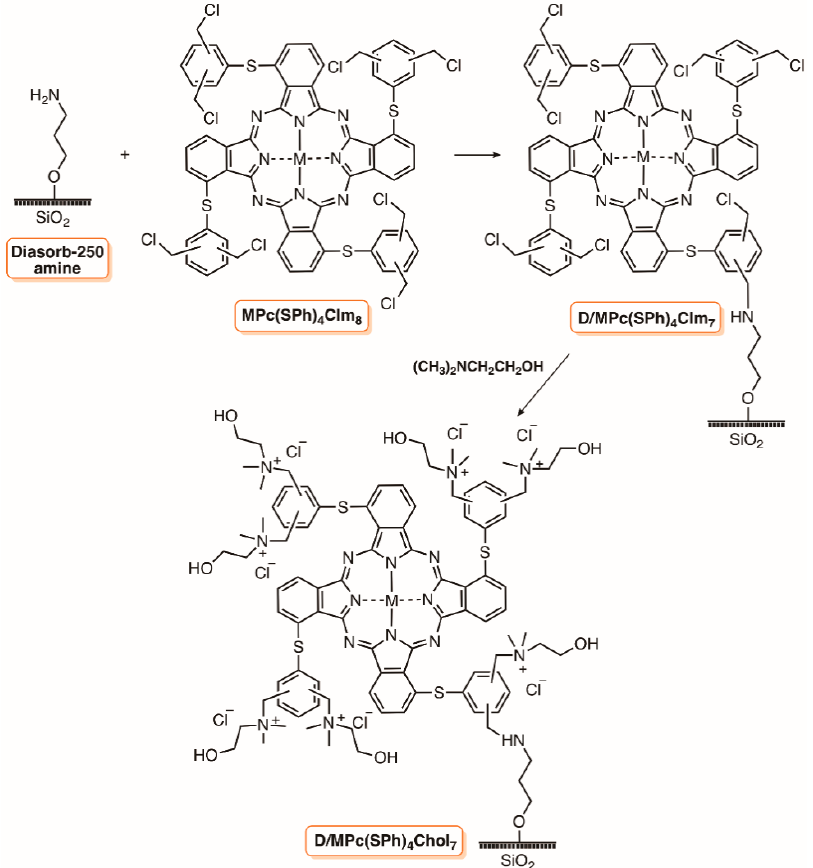
Figure 13. Synthetic route for the preparation of the metallophthalocyanines supported on silica materials (adapted from Reference [102]).